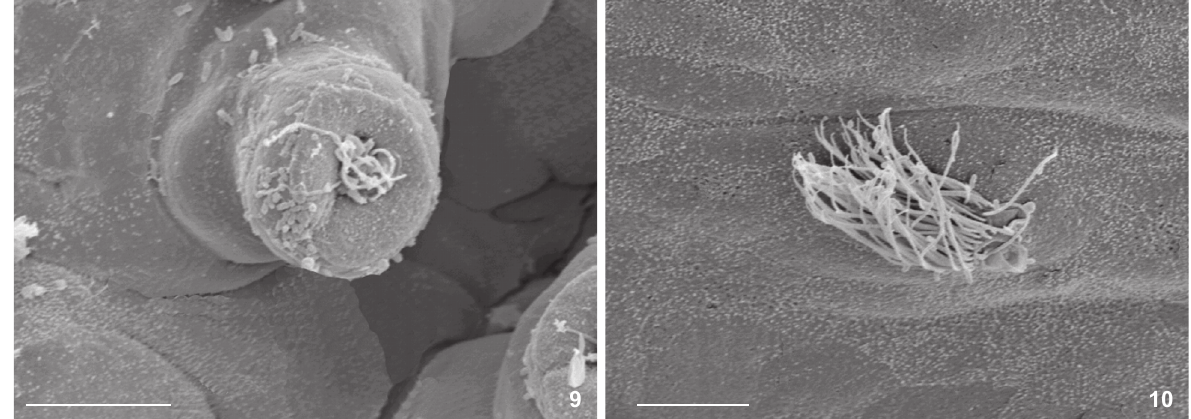
Figures 9-10. Macoma biota . Scanning electron micrographs of the cilia types: (9) tuft of short cilia at the tip of a rounded elevation on the outer epithelium of the exhalant siphon; (10) tuft of long cilia on the lumen epithelium of the inhalant siphon. Scale bars: 10